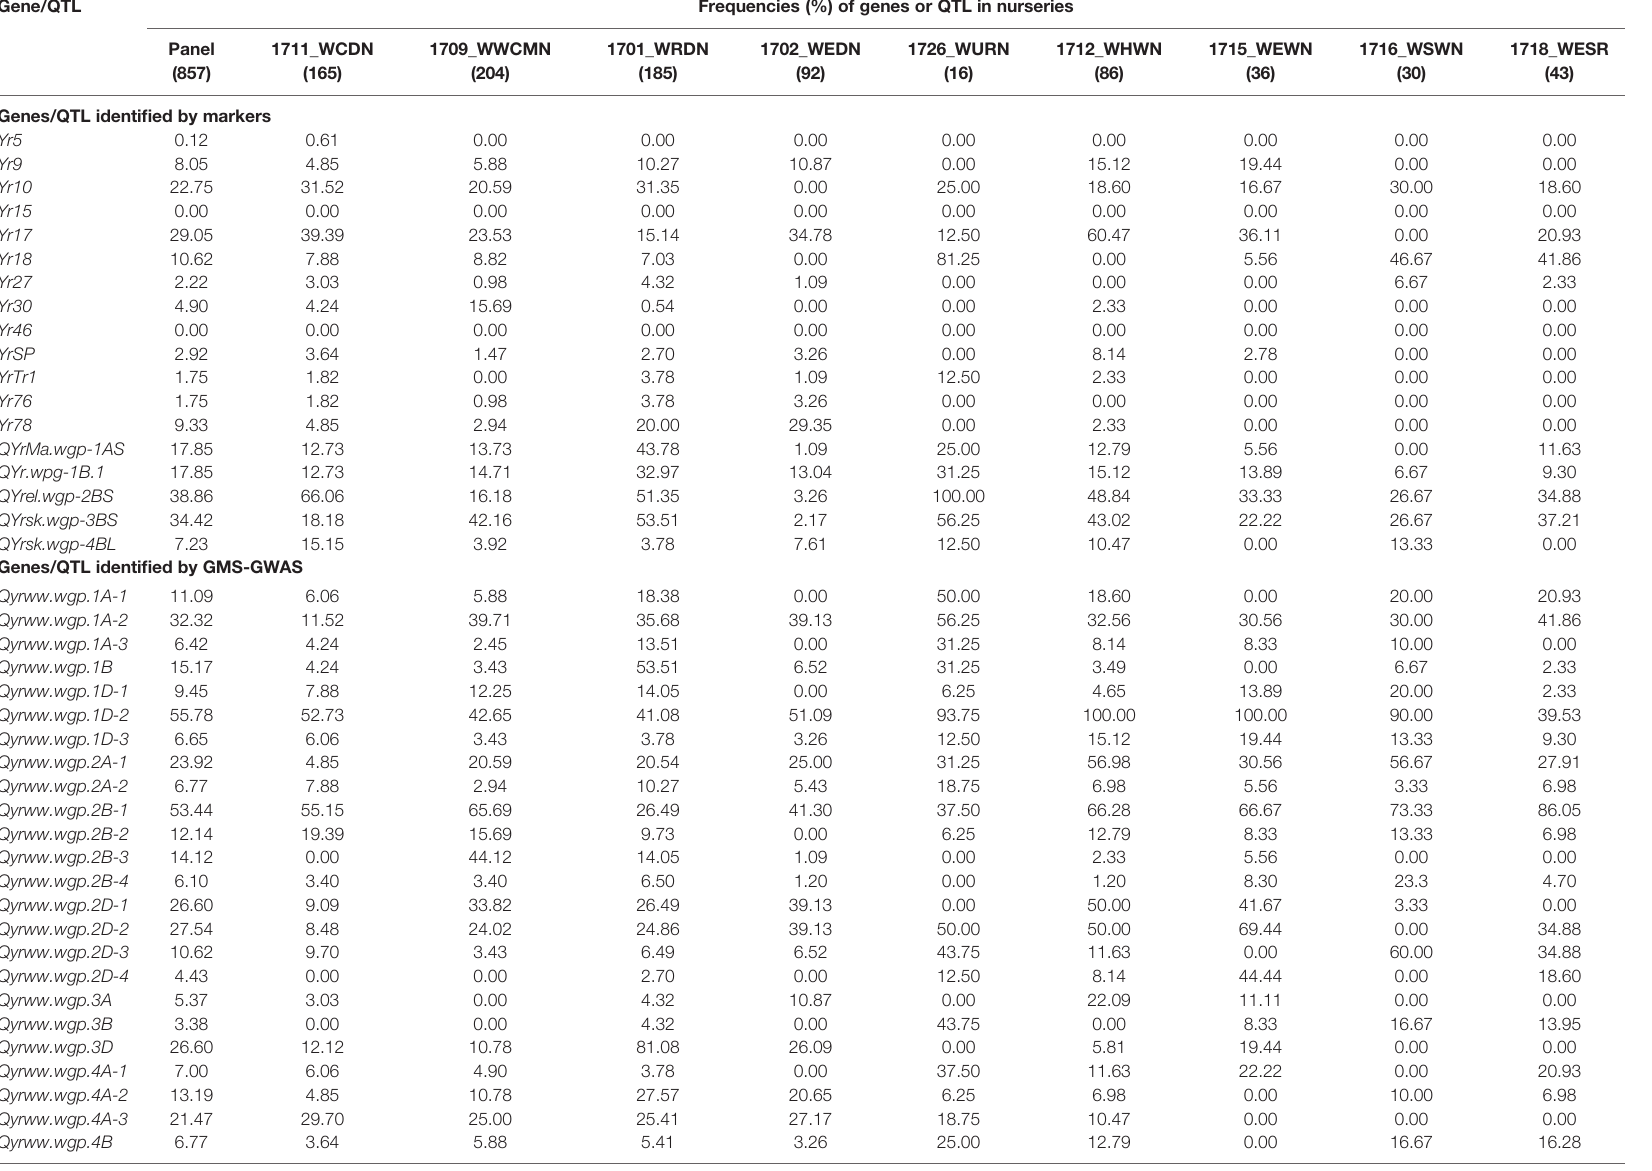
TABLE 4 | Frequencies (%) of stripe rust resistance genes or quantitative trait loci (QTL) identi fi ed with reported markers or through genotyping by multiplexed sequencing genome-wide association study (GMS-GWAS) in the winter wheat panel and nurseries. Gene/QTL